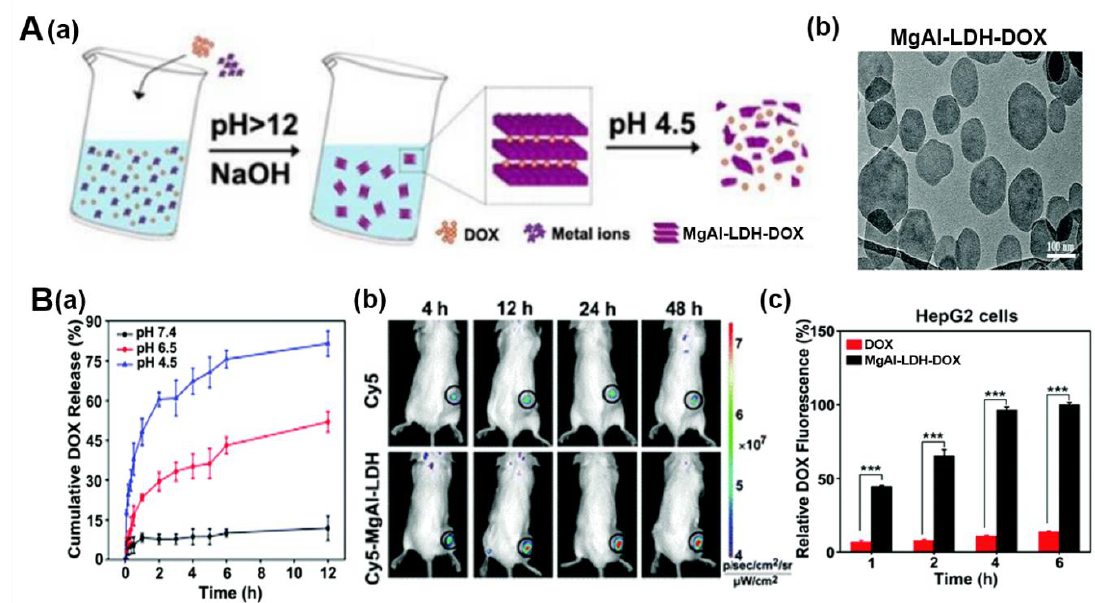
Figure 4. ( A ) ( a ) Schematic illustration of synthetic procedure and pH-responsive DOX release, ( b ) TEM image of MgAl-LDH-DOX, ( B ) ( a ) pH-responsive DOX release profiles from MgAl-LDH-DOX in PBS at 37 °C, ( b ) in vivo fluorescence images of H22 tumor-bearing mice at different time courses after intravenous injection of free Cy5 or Cy5-MgAl-LDH at the Cy5 dose of 0.3 mg/kg, respectively, ( c ) intracellular DOX content in HepG2 cells treated with free DOX or MgAl-LDH-DOX at DOX concentration of 3 μg/mL for different time intervals by flow cytometry, reproduced from [23], with permission from the Royal Society of Chemistry, 2018.